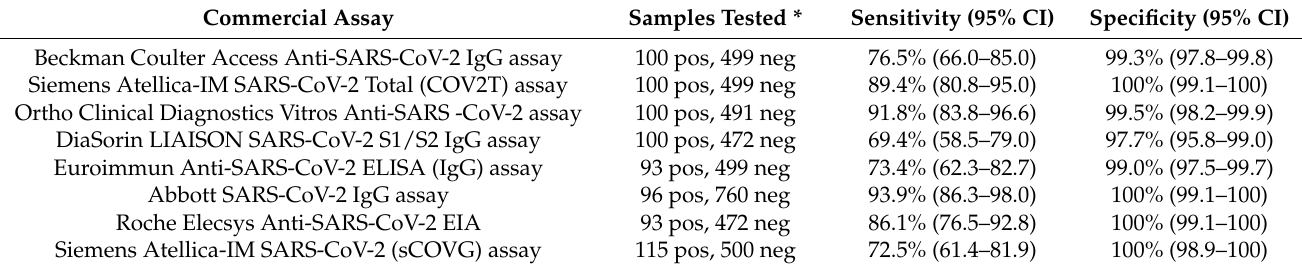
Table 2. Summary of SARS-CoV-2 commercial antibody assay kit performance studies conducted by Public Health England,